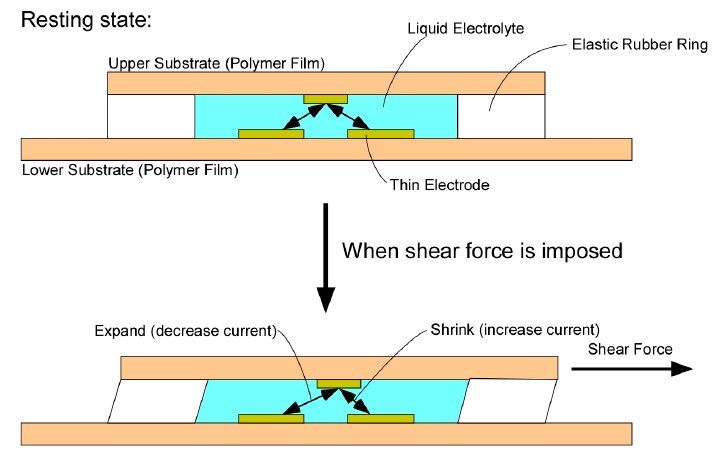
Figure 1. Schematic representation of the operating principle of the shear force sensor. The pictures show the side view of the sensor in the resting state and the shear force-imposed state.